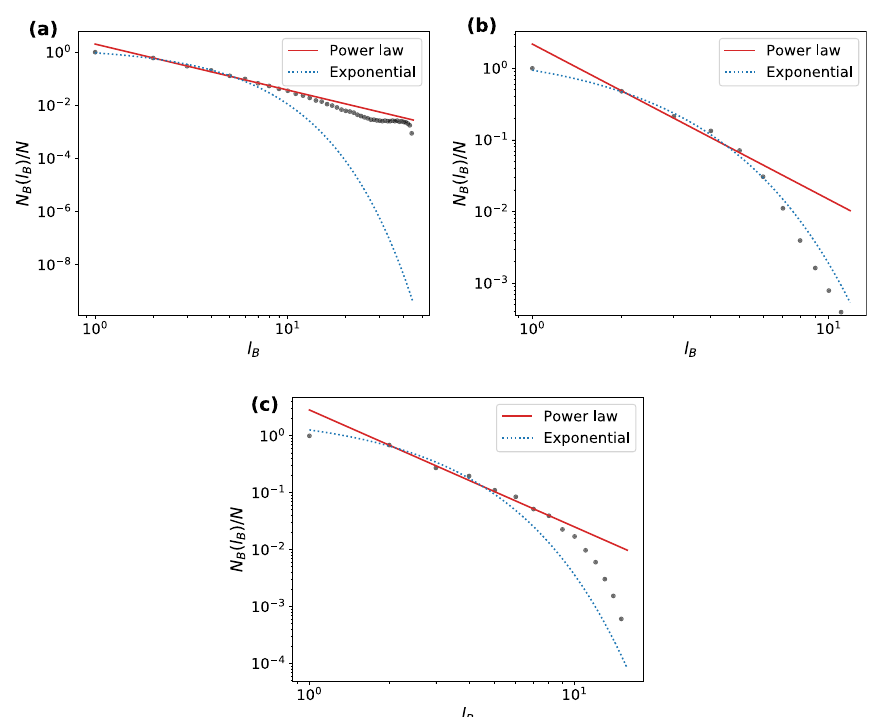
Fig. 1 Results of fitting power law and exponential curves to some real networks, illustrated on log‑log plots. a Brain network with R = 0.07 b Social network with R = 3.3 c Metabolic network with R =